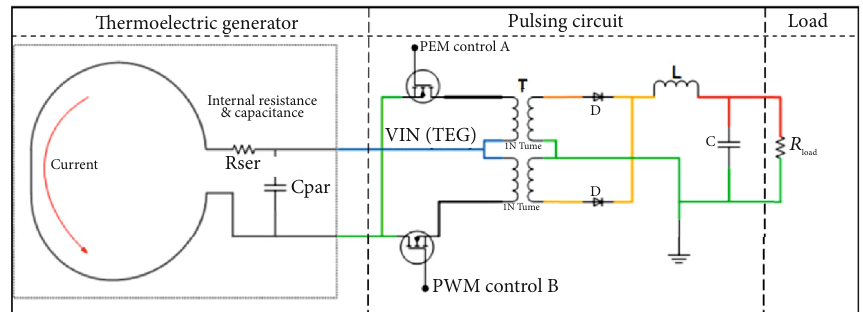
Figure 10: Pulsing TEG electrical output power using MOSFETs (adapted from [21,